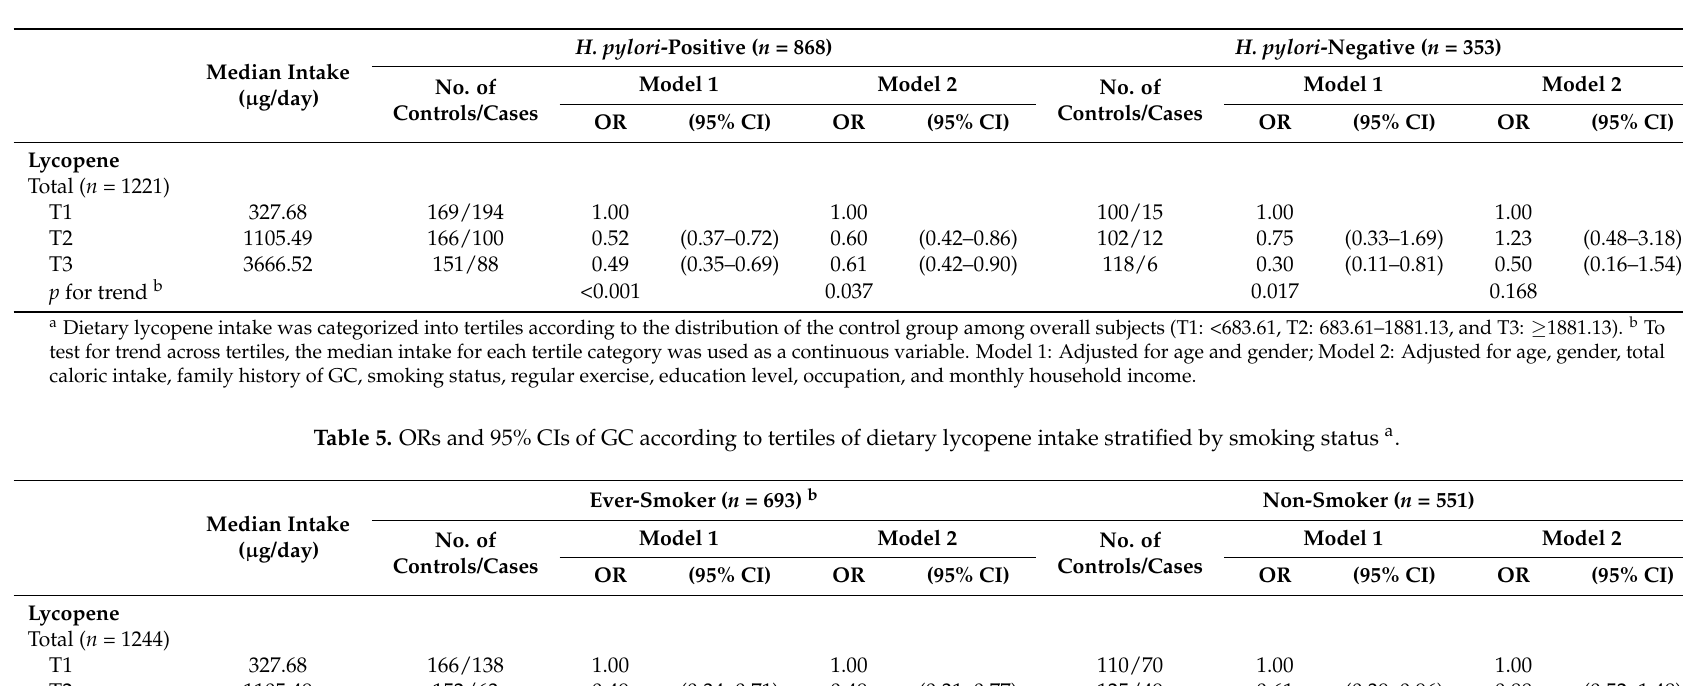
Table 4. ORs and 95% CIs of GC according to tertiles of dietary lycopene intake stratified by H. pylori infection status a